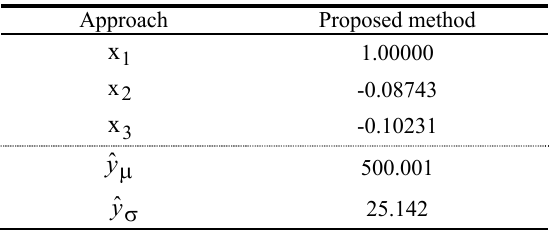
Table 7. The optimal solution for the printing ink problem with improved modeling by Zeybek et al. [35] Approach